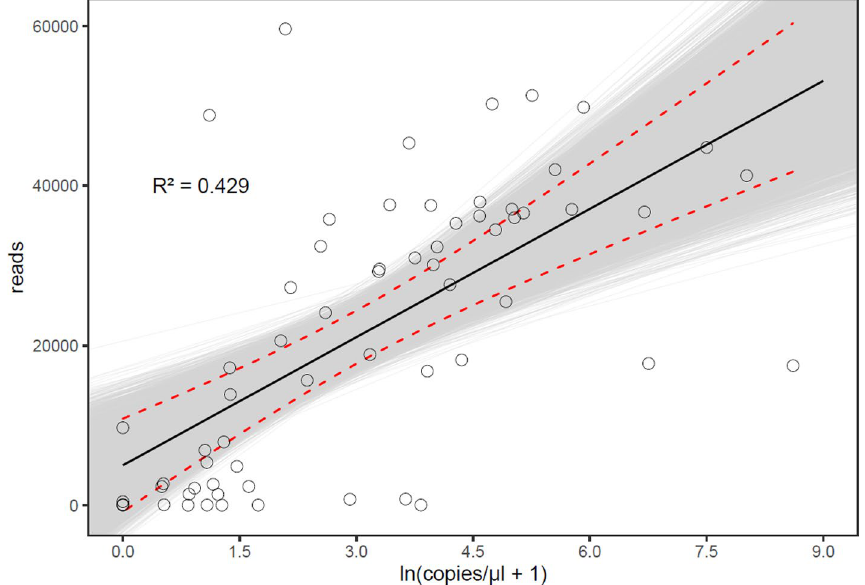
Figure 2. Correlation of copies/µl and read numbers of the plant-specific trn L c-h target fragment in regurgitates of Pseudoophonus rufipes collected at 0, 4, 8, 16, 24, 32, 48, 64, 72 and 96 h after feeding on 1–3 seeds of T. officinale. Dots in the scatterplot ( ○ ) are measured values, black bold lines are predicted values of a linear regression model of copies and reads, dashed lines are 95% confidence intervals, shaded area marks boot- strapped 95% confidence interval, and R 2 indicates goodness of